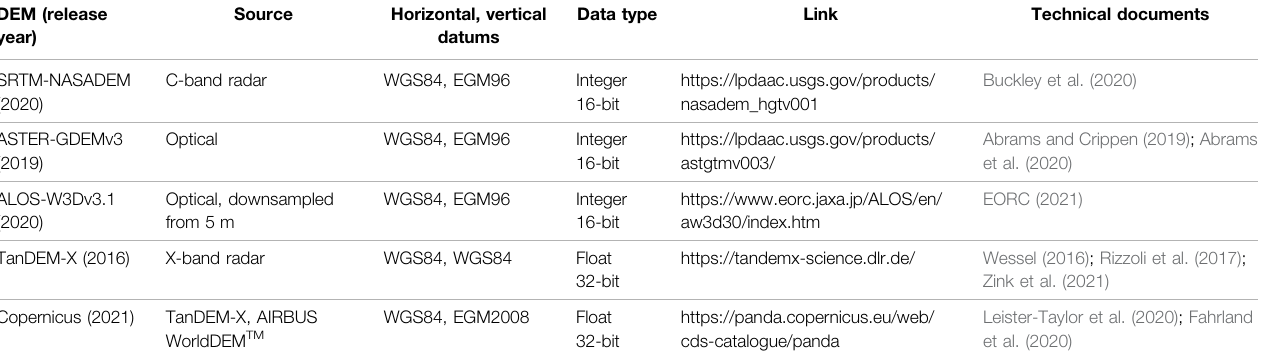
TABLE 1 | Global 1 arcsec ( ∼ 30 m) DEMs